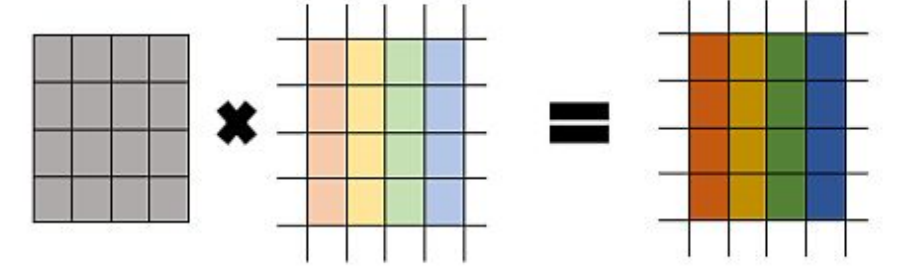
Figure 1. Elliptic Curve Cryptography (ECC) with hill